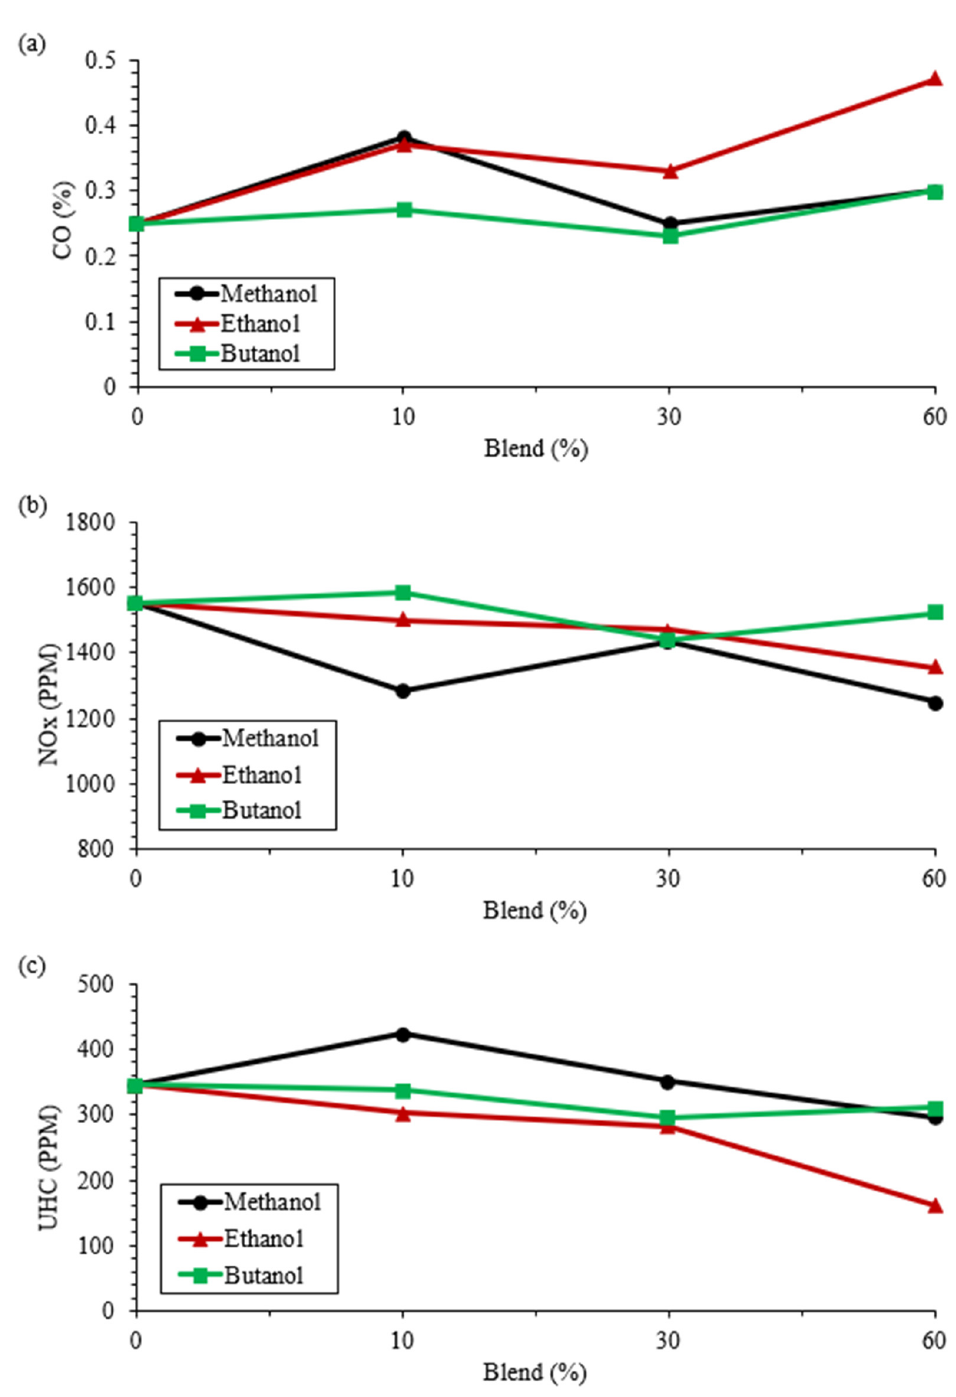
Figure 8. Effect of blend percentages of methanol, ethanol, and butanol on exhaust emissions of SI engine ( a ) CO, ( b ) NO x , and ( c ) UHC [61].